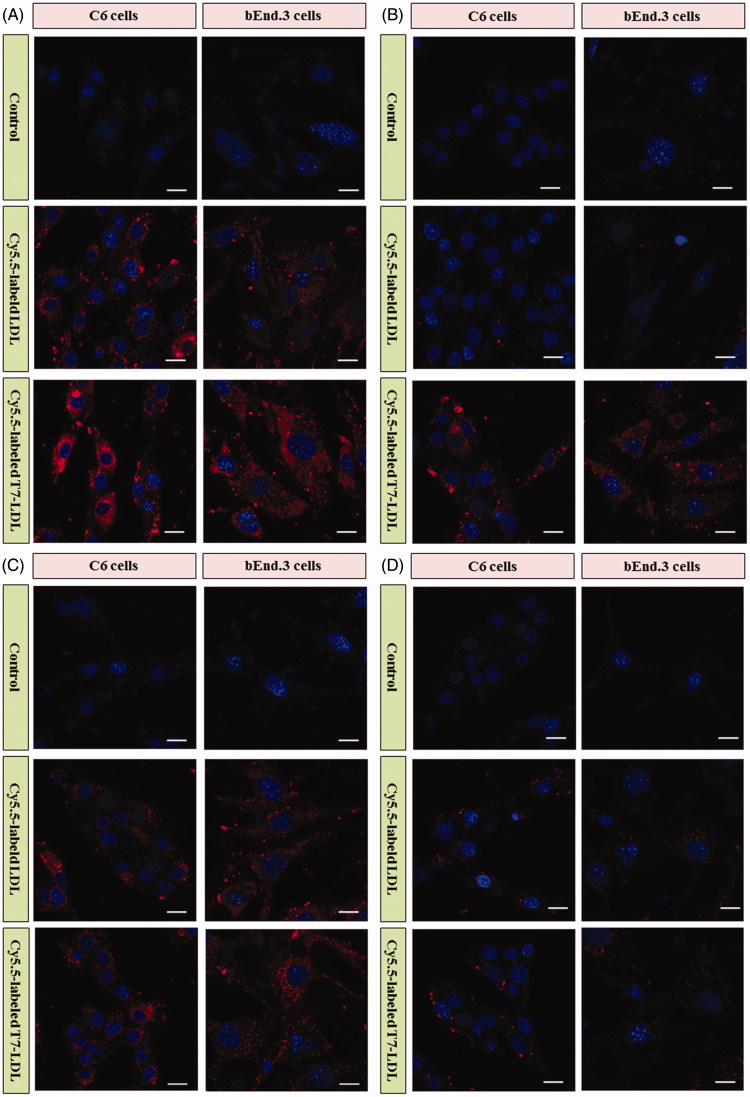
(A) Cellular uptake of various formulations into cells. (B) Cellular uptake of various formulations into cells with excess parent LDL. (C) Cellular uptake of various formulations into cells with excess free T7. (D) Cellular uptake of various formulations into with excess free T7 and parent LDL. Intracellular fluorescence was captured by a confocal laser scanning microscope.